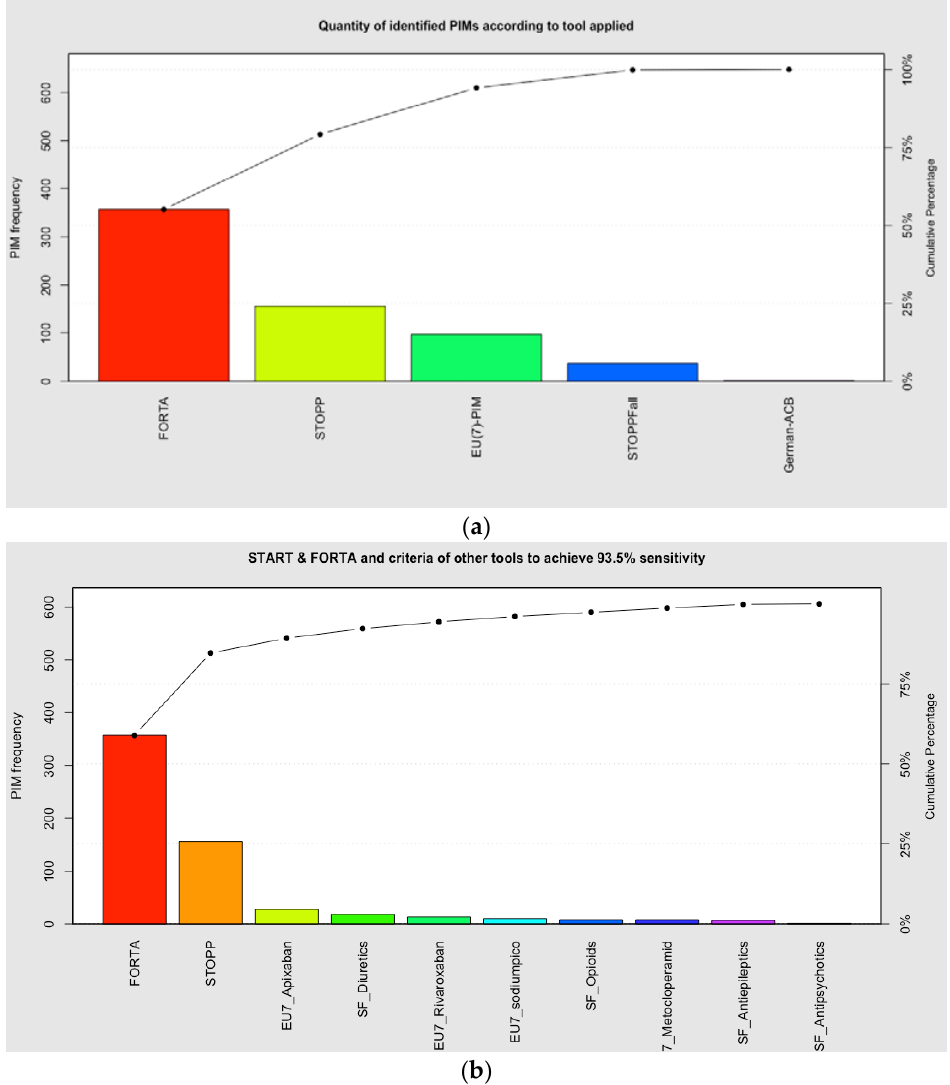
Figure 2. Pareto chart showing the number of distinct PIMs detected by PIM instruments in descending order of PIM prevalence, and the cumulative sensitivity of PIM detection achieved by adding distinct items from each instrument. Panel ( a ) shows the effects on the cumulative sensitivity of adding all distinct items from each instrument. Panel ( b ) shows the effects on the cumulative sensitivity of adding to FORTA C/D and STOPP the most prevalent PIMs from other